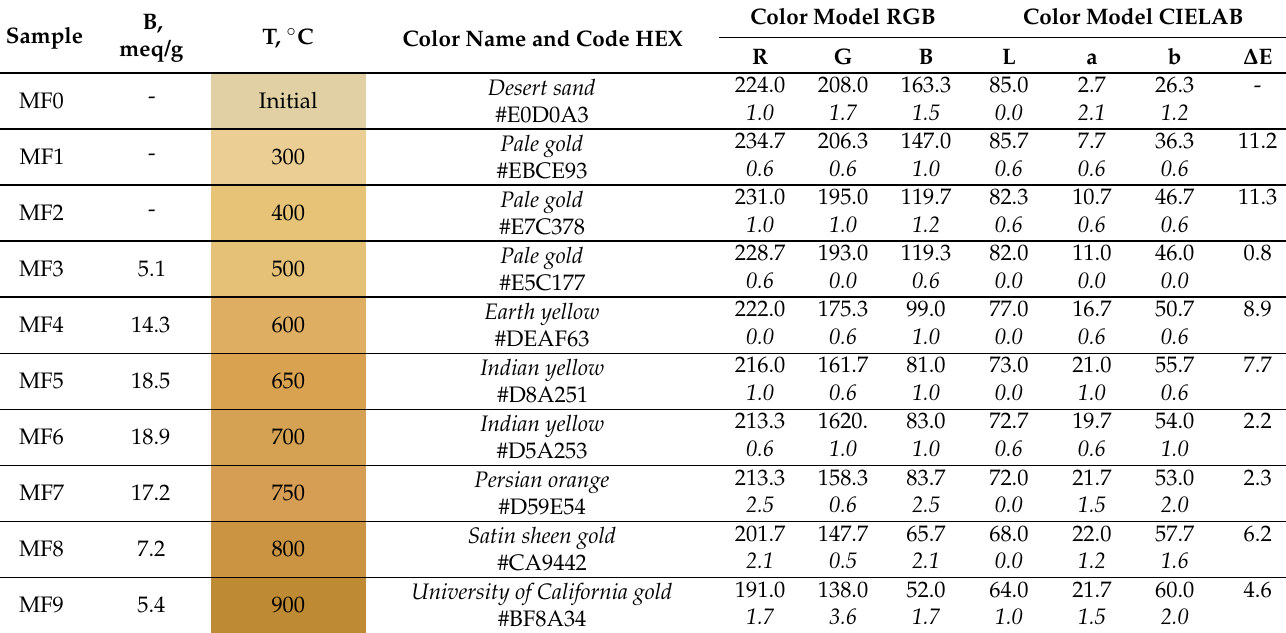
Table 3. Color characteristics of the samples of the MF